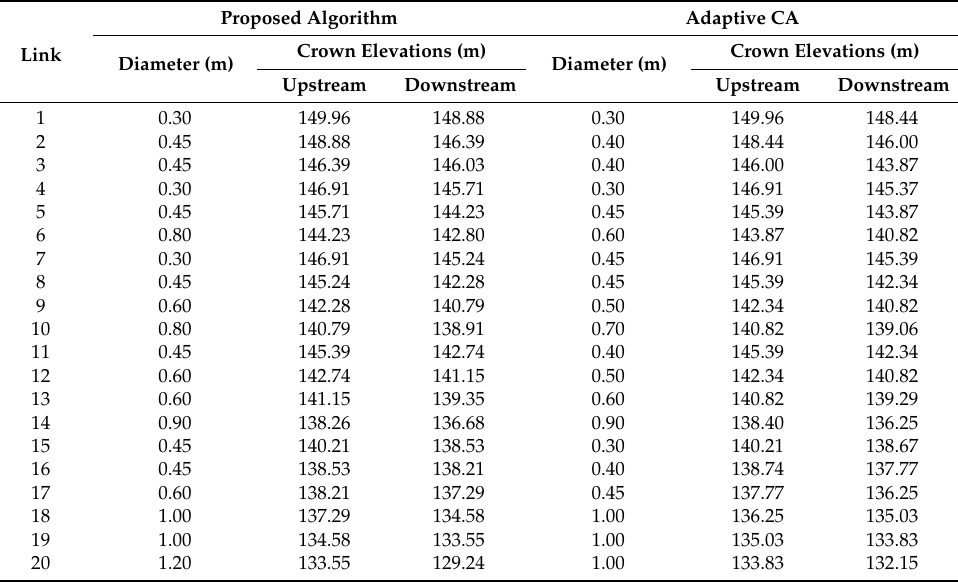
Table 4. Comparison of the results for the proposed method and the Adaptive CA.